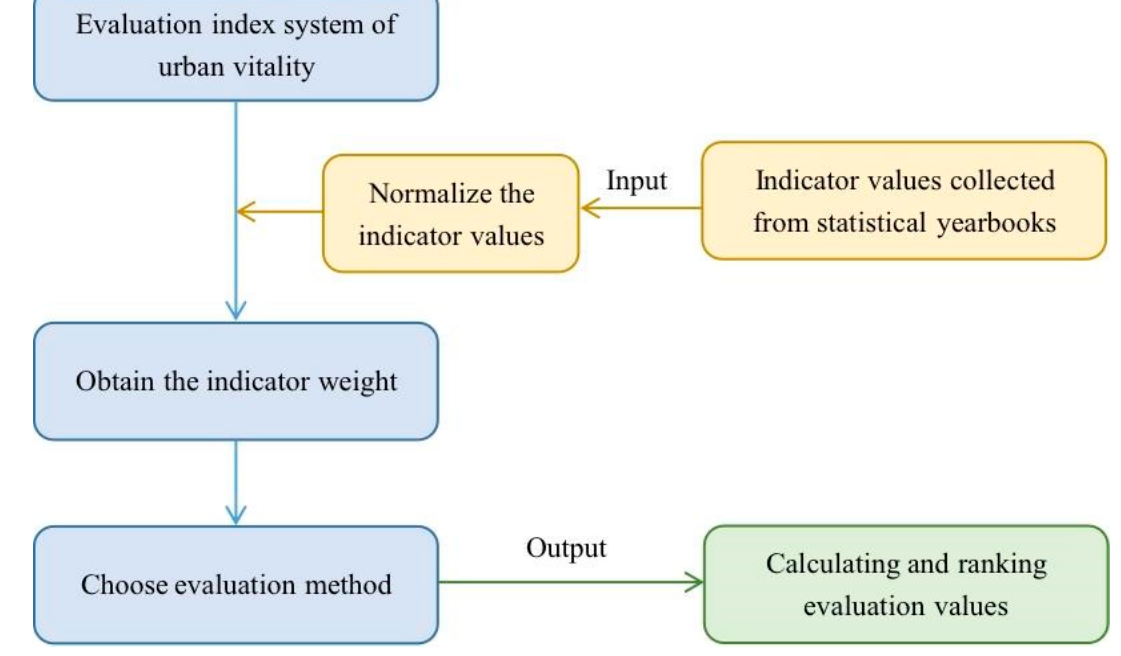
Figure 2. Urban vitality evaluation process.